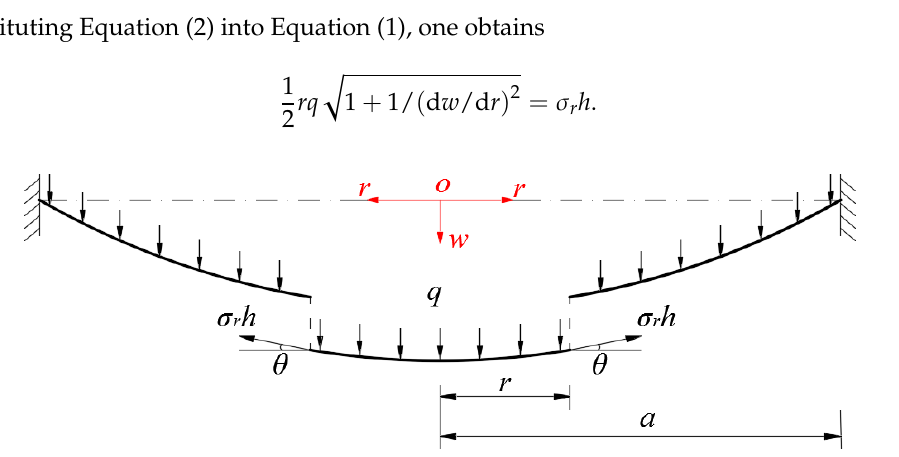
Figure 2. Sketch of the static equilibrium of the central portion ( r ≤ a ).